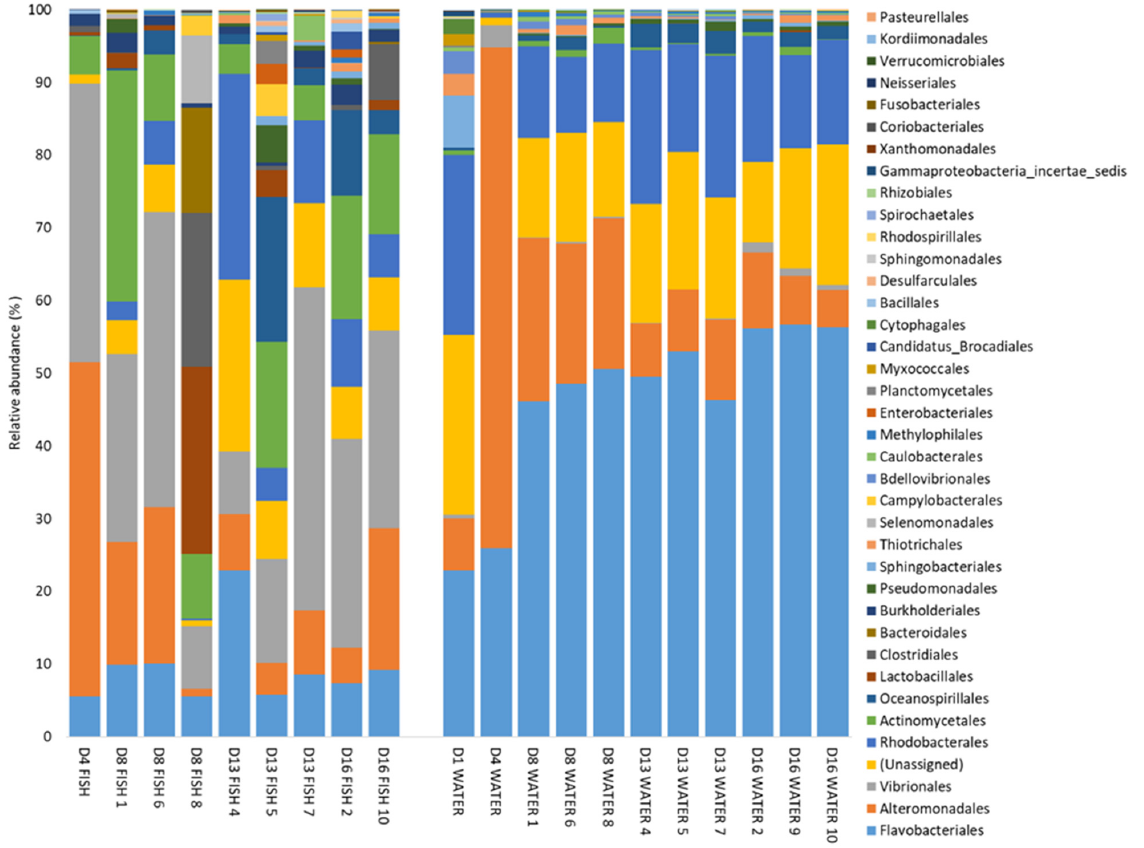
Figure 3. Taxa summary of bacterial orders detected at a relative abundance higher than 0.1% in at least one sample, at 1 to 16 dph (D1–D16). Numbers indicate the rearing bottle sampled. One fish sample consists of five pooled larvae from one rearing bottle.